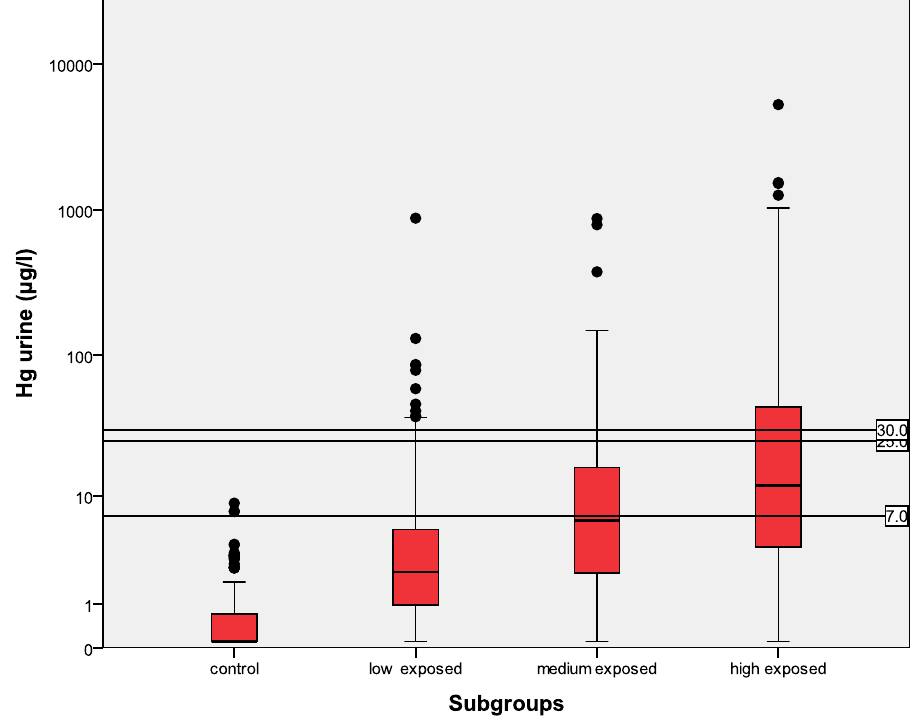
Figure 1. Urine mercury concentrations in four exposure groups (threshold values HBM I